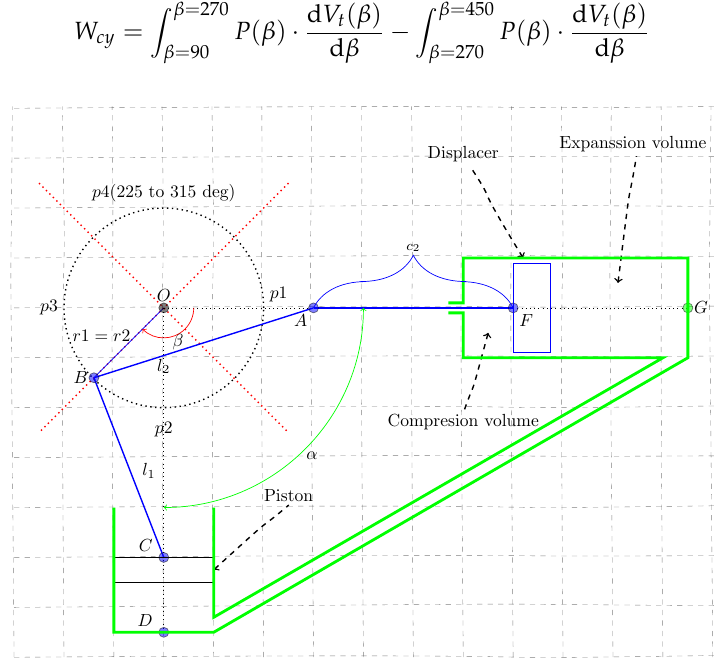
Figure 4. Gamma configuration with crankshaft